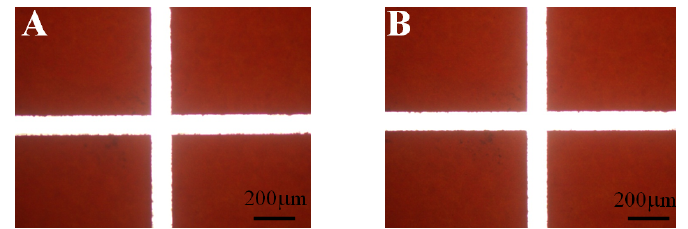
Figure 1. Appearance of the cross-junction microchannel in the PFR chip before ( A ) and after ( B ) contact with chloroform for 24